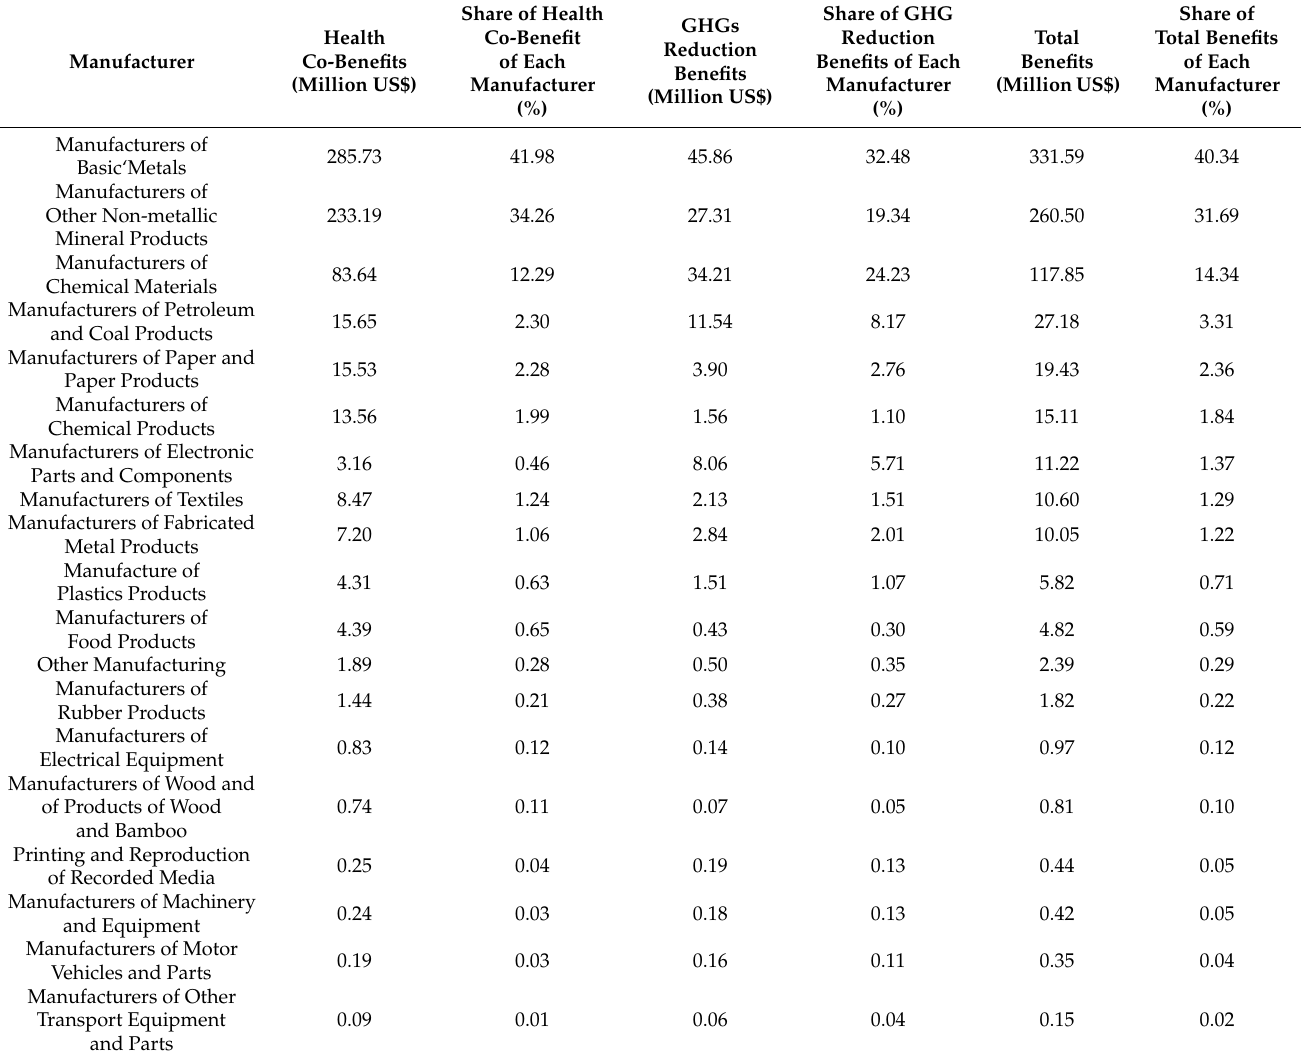
Figure 6. The average benefit for every unit fee rate under scenario 1 in 2023–2030. Table 5. Health co-benefits and GHG reduction benefits for 25 manufacturers simulated in scenario